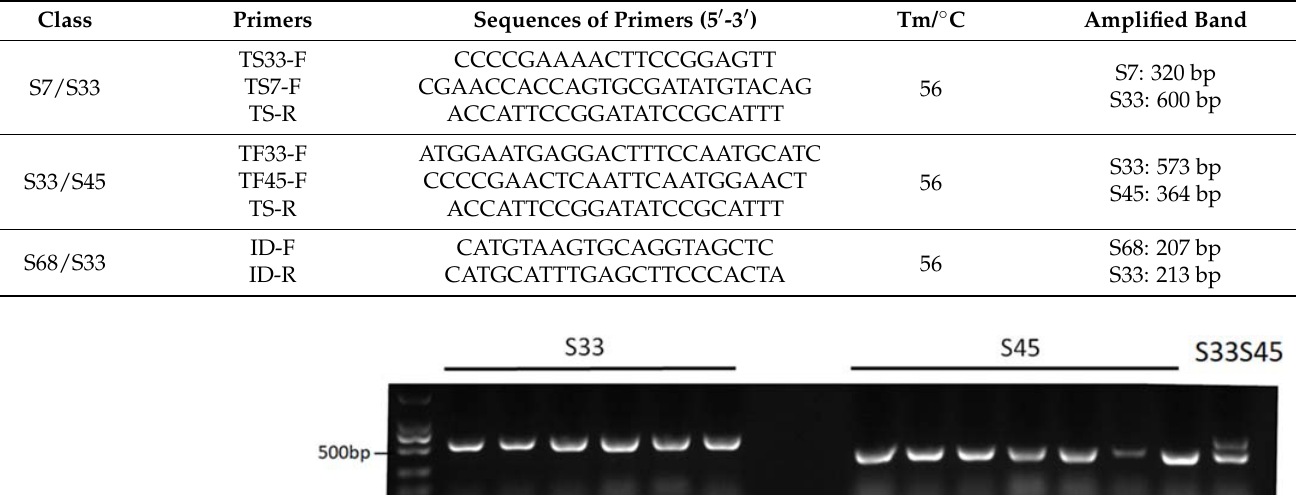
Table 2. Primers of class I S ‐ haplotypes identification system.